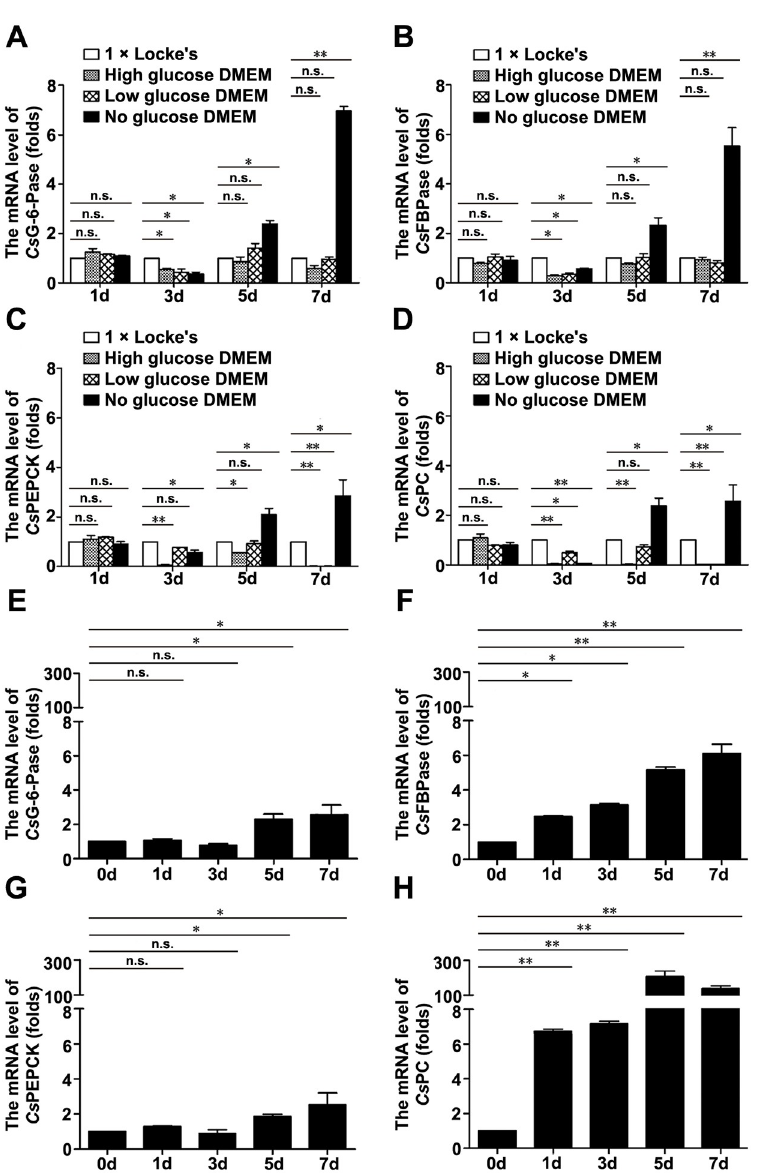
Fig 3. The mRNA levels of Cs G-6-Pase, Cs FBPase, Cs PEPCK, and Cs PC in 1 × Locke’s and different DMEM. The mRNA levels of Cs G-6-Pase (A), Cs FBPase (B), Cs PEPCK (C), and Cs PC (D). Time course of Cs G-6-Pase (E), Cs FBPase (F), Cs PEPCK (G), and Cs PC (H) mRNA levels in no glucose DMEM. ANOVA was used to analyze the comparisons. � P < 0.05 and �� P < 0.01 versus 1 × Locke’s (A-D) or 0 d (E-H); n.s., not